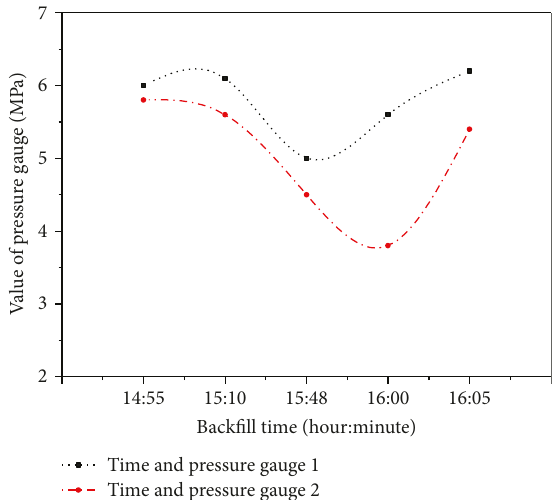
Figure 16: BWR and slump rate of